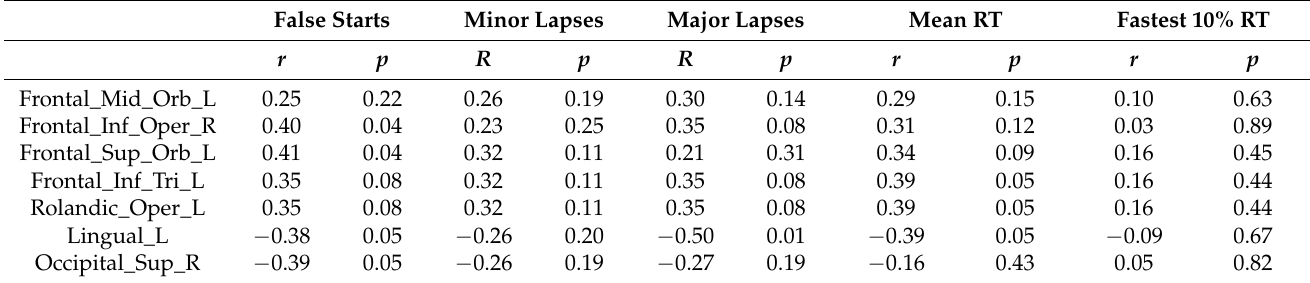
Table 3. Correlation between PVT changes and CBF